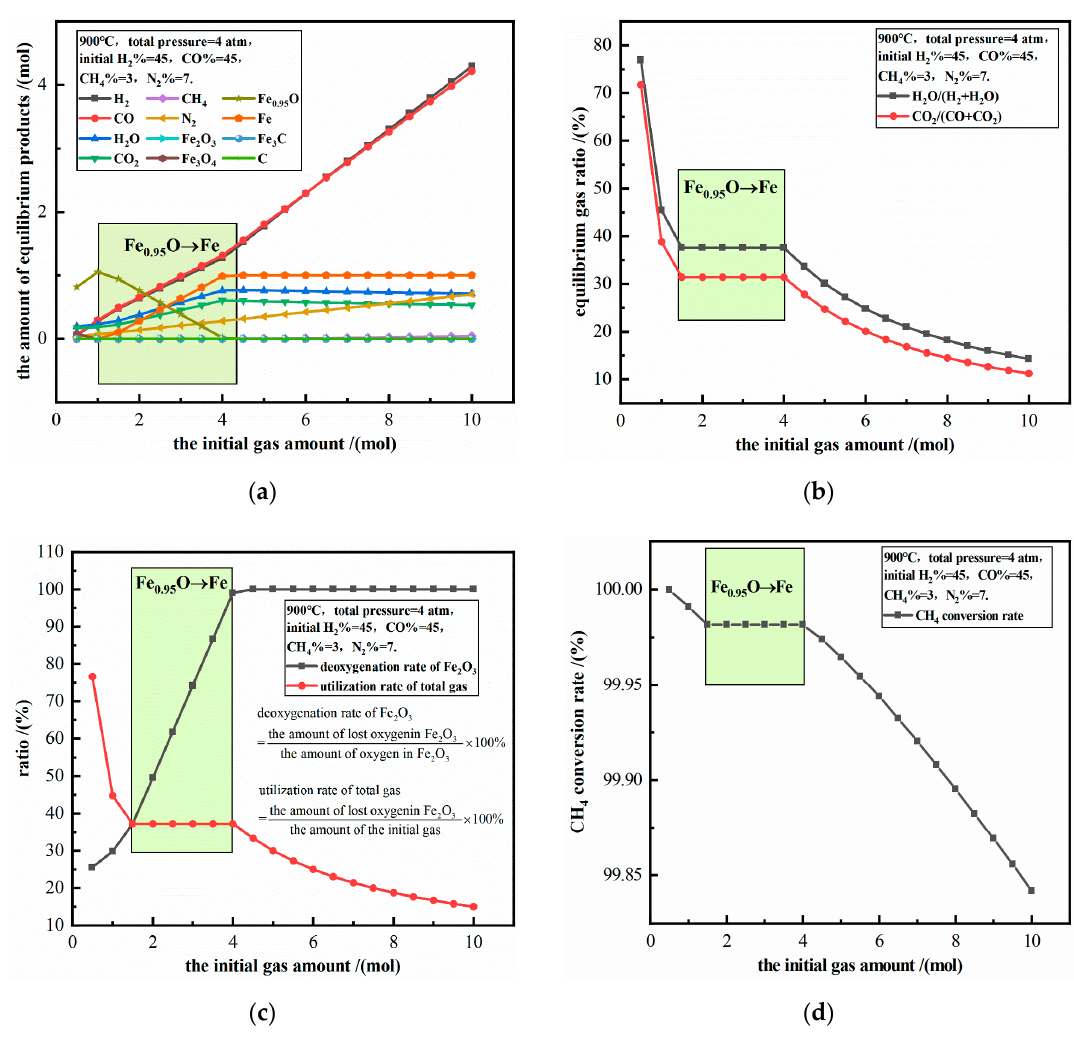
Figure 2. The initial gas concentration is H 2 % = 45, CO% = 45, CH 4 % = 3, N 2 % = 7, the total pressure is 4 atm, and the temperature is 900°C. ( a ) the amount of equilibrium products; ( b ) equilibrium gas ratio; ( c ) deoxygenation rate of Fe 2 O 3 and utilization rate of total gas; ( d ) CH 4 conversion rate.